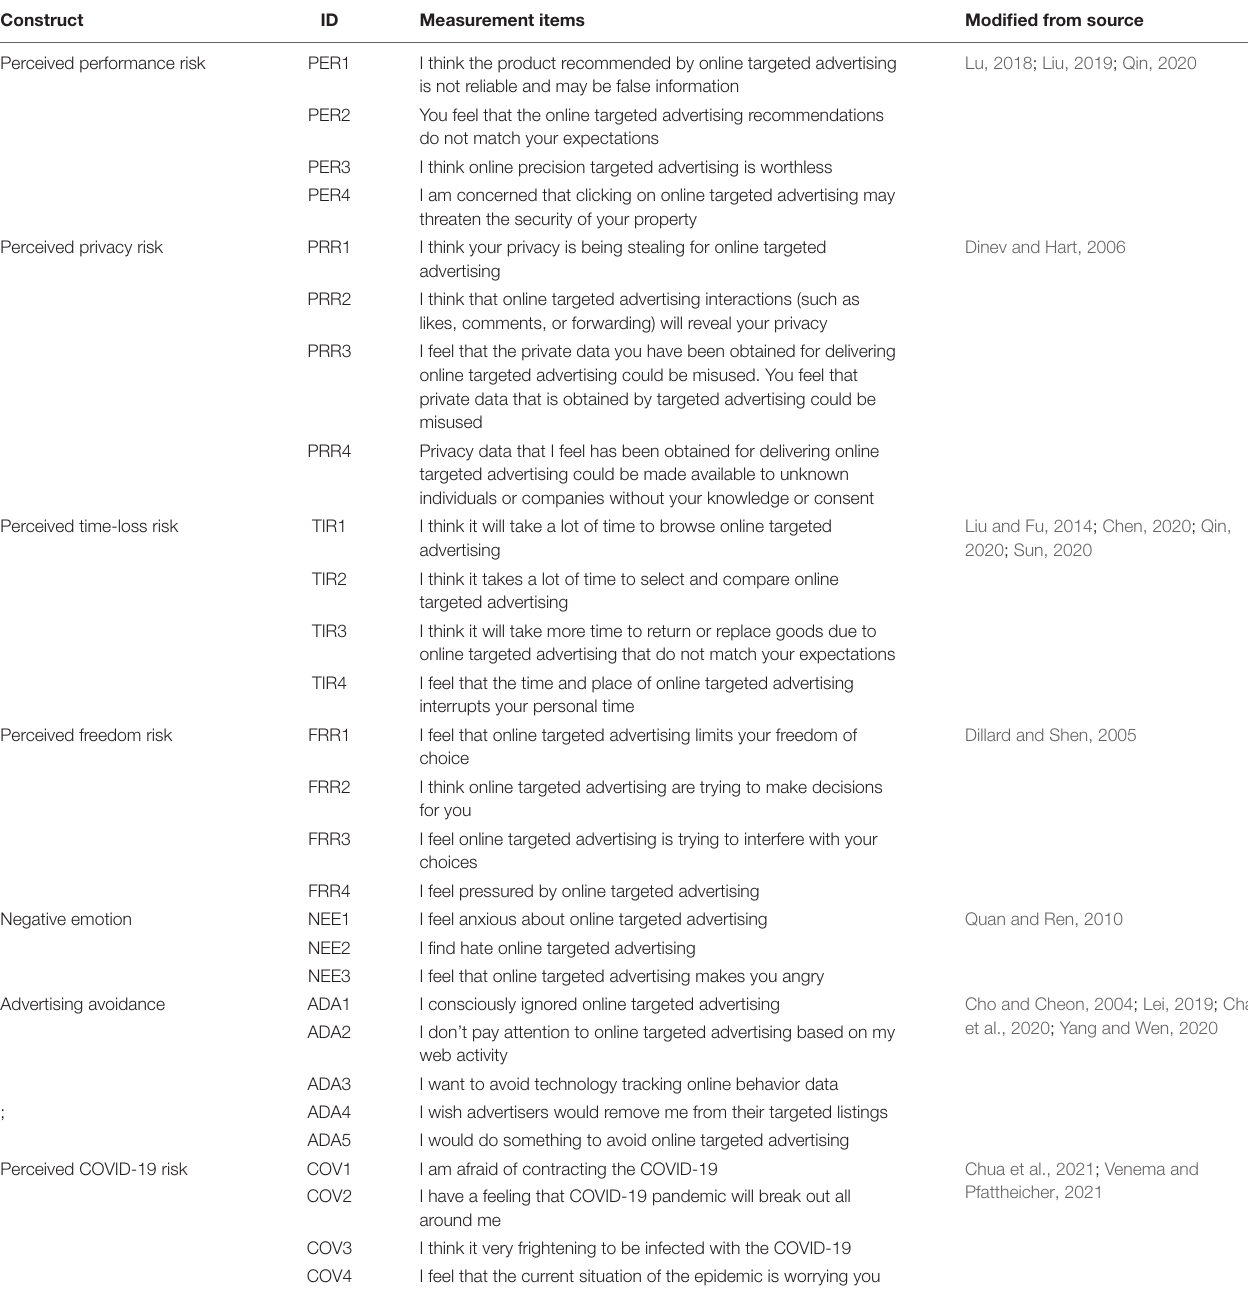
TABLE 2 | Measurement items and constructs. Construct ID Measurement items Modified from